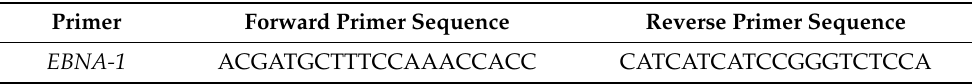
Table 1. List of primer for screening spontaneous integrations of episomal plasmid vectors. Primer Forward Primer